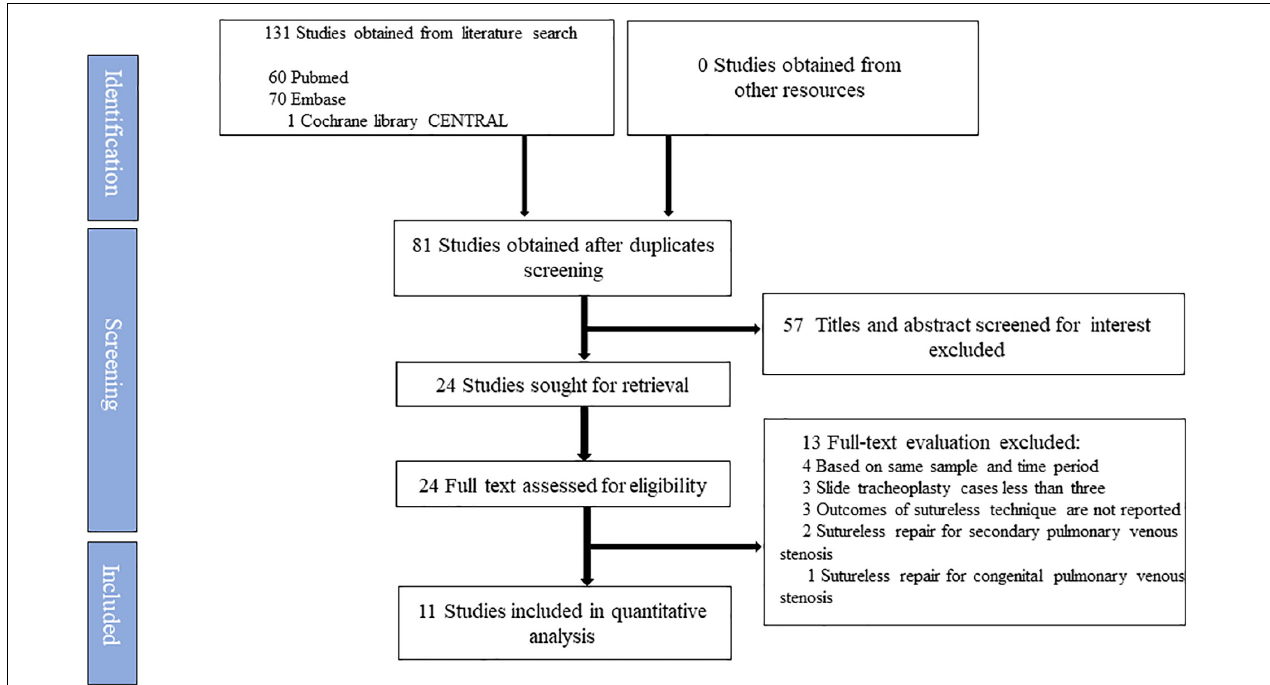
FIGURE 2 | Flow diagram according to the updated Preferred Reporting Items for Systematic Review and Meta-Analysis (PRISMA) protocol recommendations.